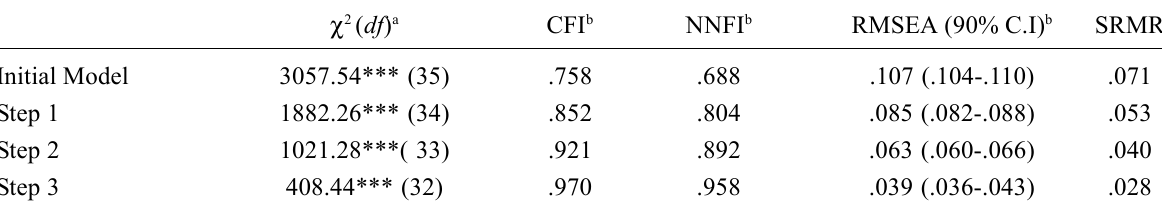
Fit Indexes of the Initial Model and the Model with the Introduction of Parameters (error